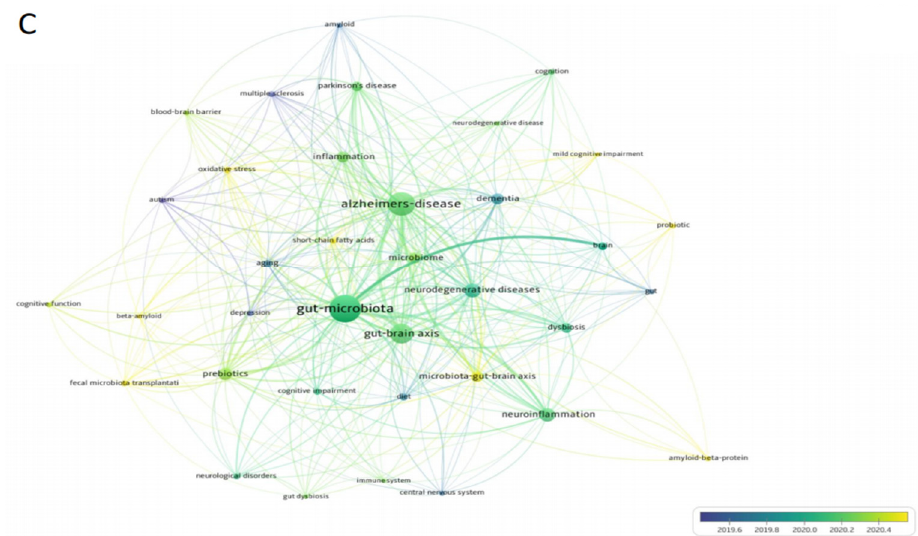
Figure 6. Co-occurrence analysis of author keywords and top 10 keywords on COVID-19 and sleep related research. (( A ): the most frequently used keywords. ( B ): Co-occurrence network analysis